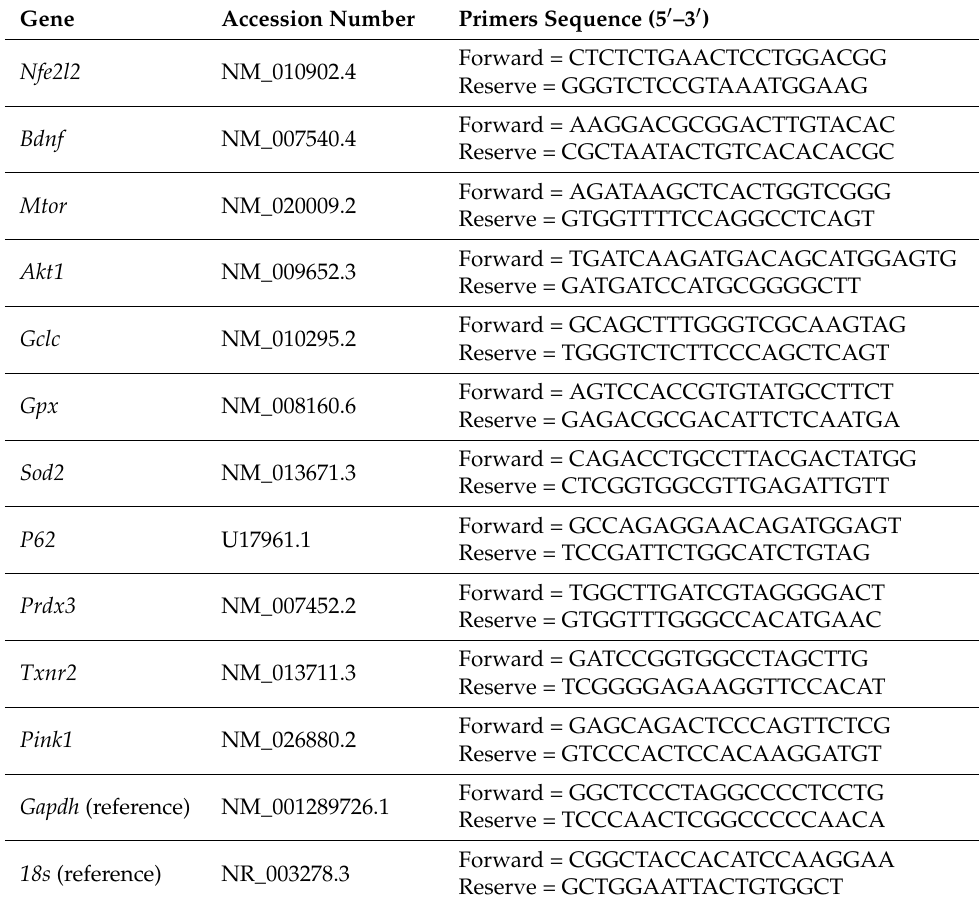
Table 3. Primers that were used to analyze gene expression.